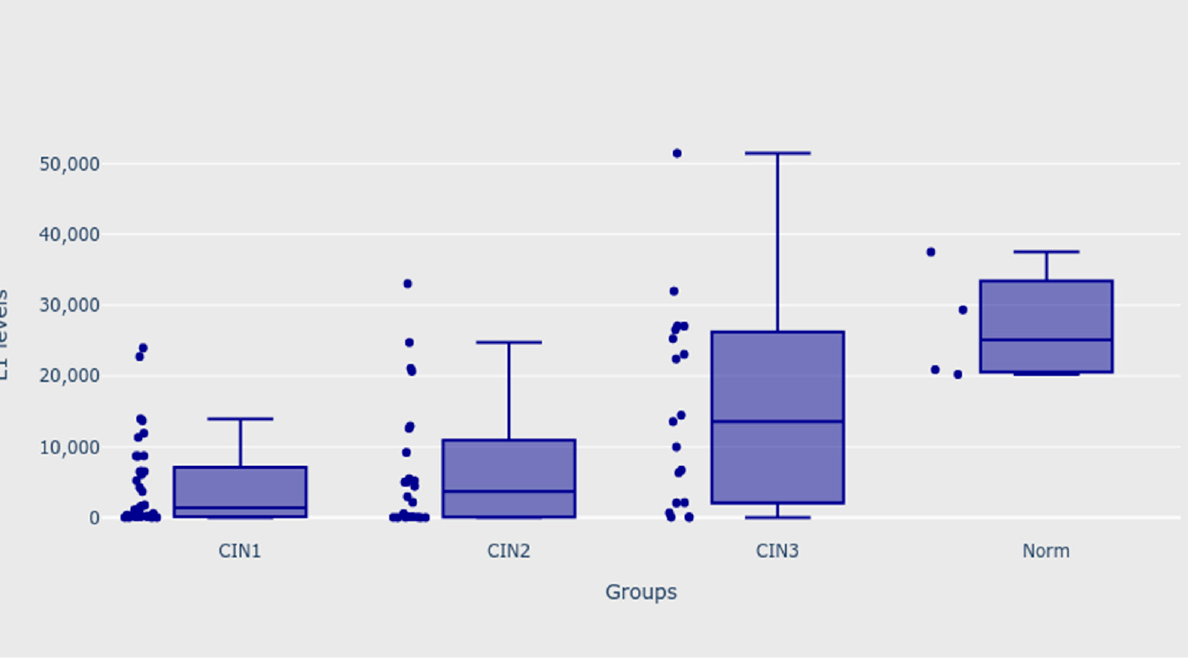
Figure 3. Levels of L1—CIN 1, CIN 2, CIN 3, and norm groups. No correlation between the HPV major capsid protein (L1) and E4 protein level was detected (tau-b = 0.004; p = 0.952), as shown in Figure 4.